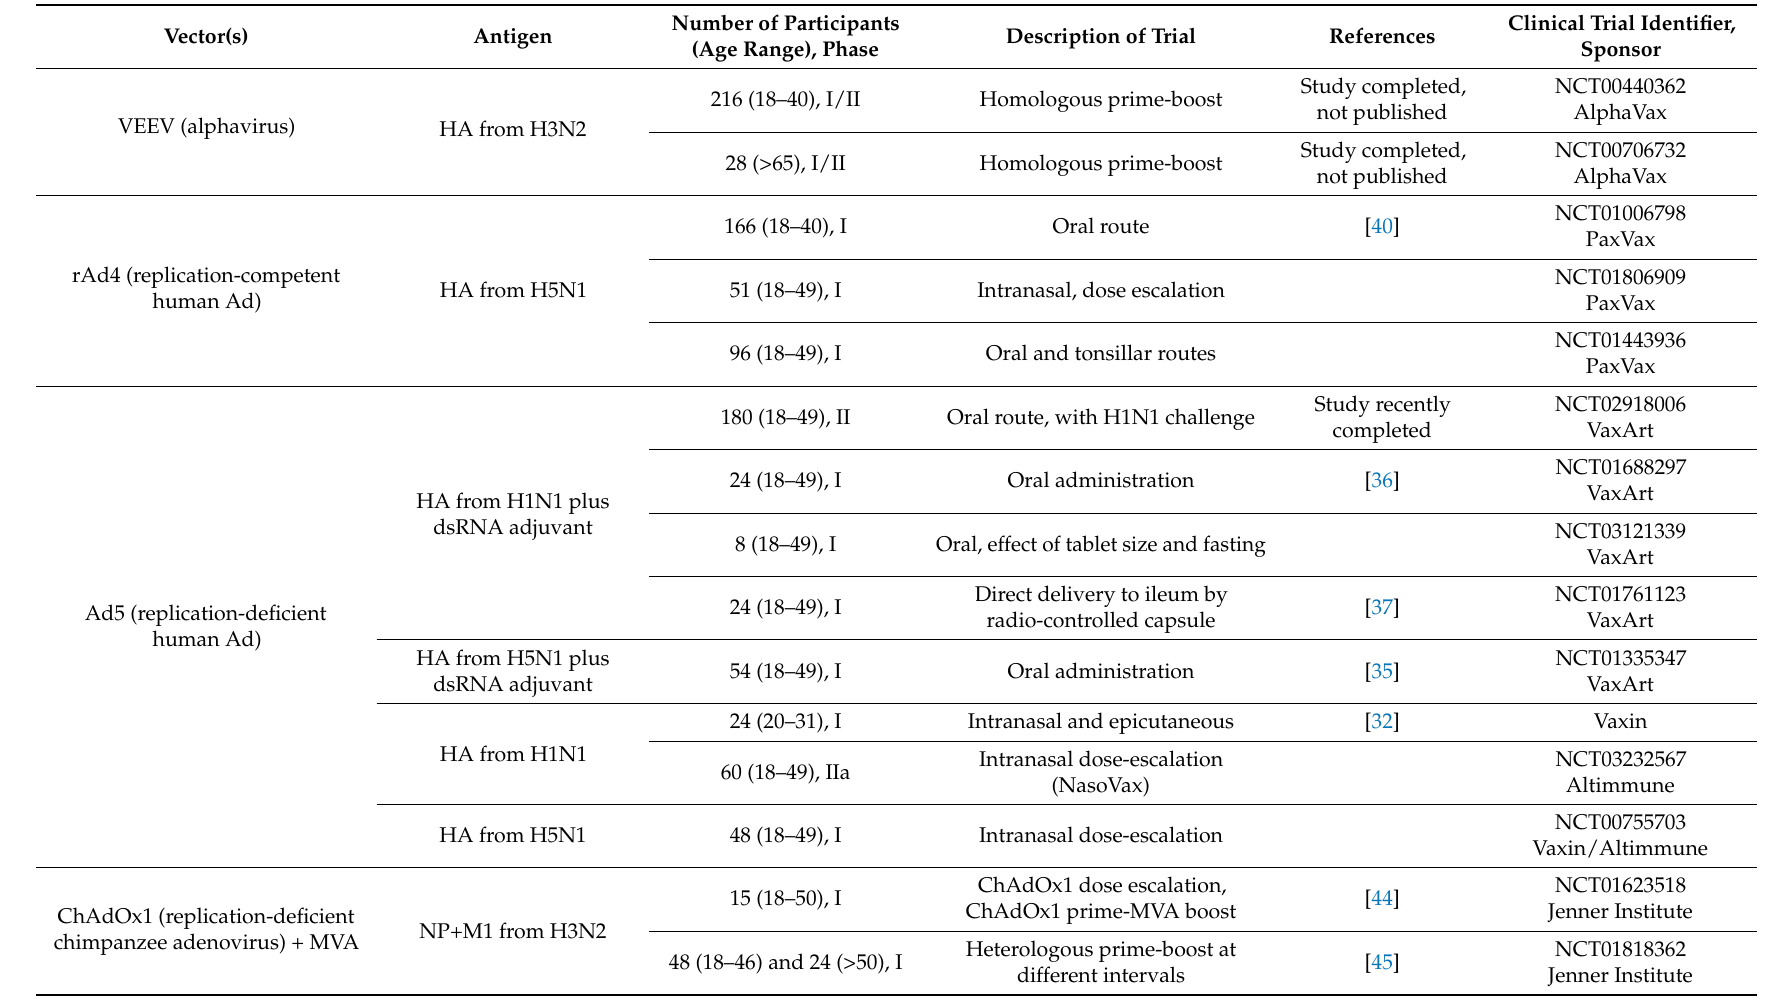
Table 2. Viral-vectored influenza A vaccines in ongoing or completed clinical trials. VEEV: Venezuelan equine encephalitis virus. MVA: modified vaccinia virus Ankara. Ad: